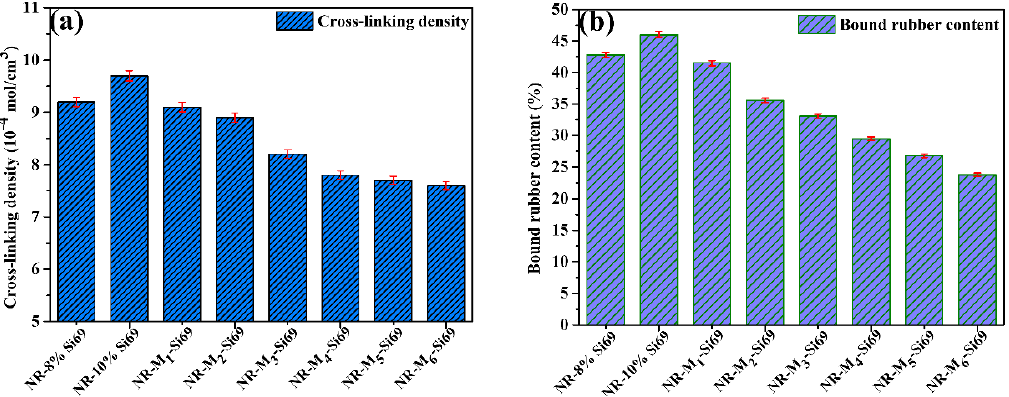
Figure 3. ( a ) Cross − linking density and ( b ) bound rubber content.